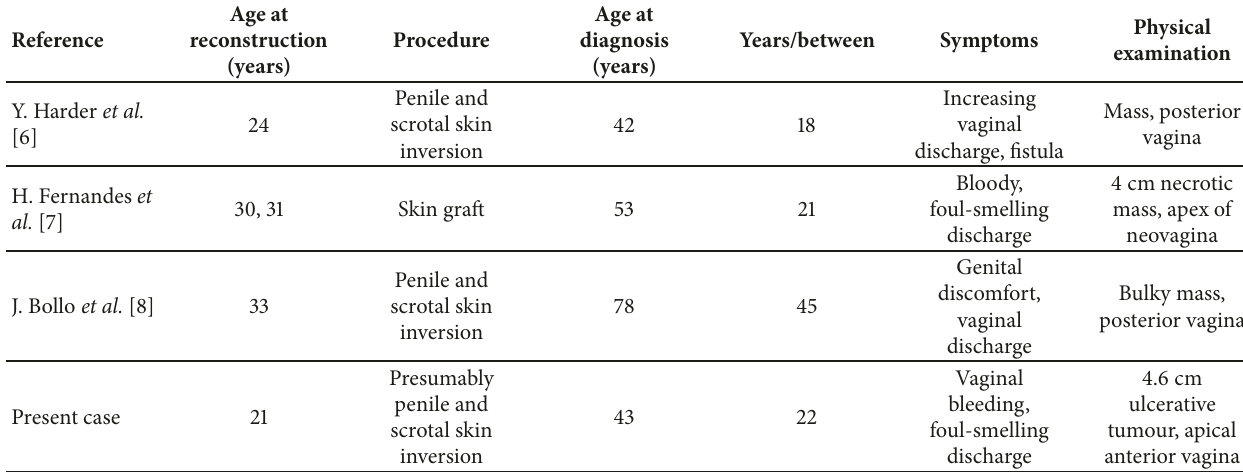
Table 1: Age at reconstruction and diagnosis; time between procedure, symptoms, and physical